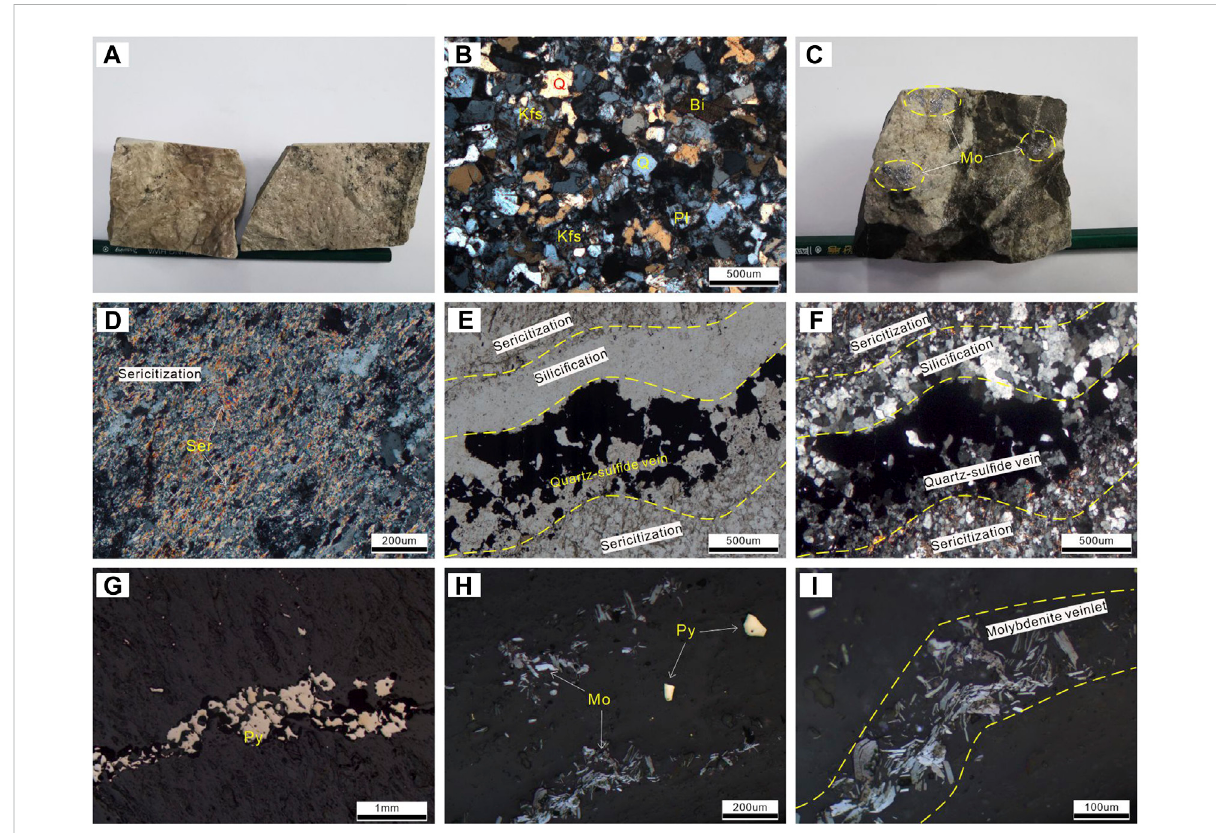
FIGURE 3 Photographsandphotomicrographsofthealkali-feldspargraniteandore (A) Handspecimenofthealkali-feldspargranite,withgranitictexture; (B) Quartz,plagioclase,potassiumfeldspar,andbiotiteinthealkali-feldspargranite; (C) HandspecimenofMoorewithmassaggregatestructure; (D) sericitization in Mo ore; (E) , (F) Quartz-sul fi de veins in silici fi cation and sericitization; (G) Pyrite veins; (H) , (I) Molybdenite veinlets. Q-quartz; Kf-K- feldspar; Pl-plagioclase; Bi-Biotite; Ser-Sericite; Py-Pyrite;